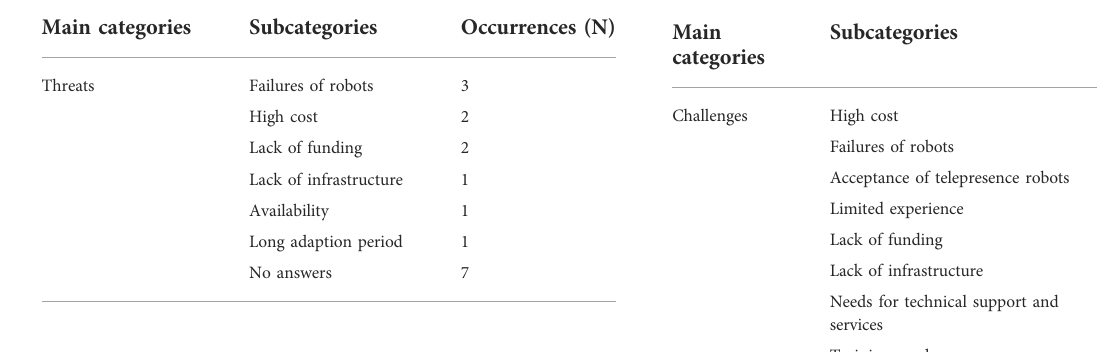
TABLE 7 Threats of TPRs. TABLE 8 Challenges of telepresence